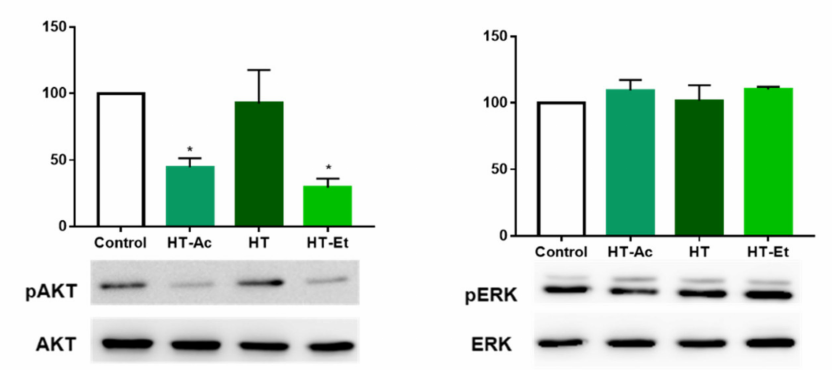
Figure 6. Effect of HT-Ac, HT, and HT-Et treatment (20 µ M, 24 h) in the phosphorylation of AKT and ERK in PC-3. Data are calculated as the ratio between pAKT/AKT and pERK/ERK levels, respectively (expressed as percent of control, set at 100%), and represent the mean ± SEM (4 experiments). Asterisks indicate significant differences compared to the control value: * p < 0.05. Abbreviations: HT, Hydroxytyrosol; HT-Ac, hydroxytyrosyl acetate; HT-Et, ethyl hydroxytyrosyl